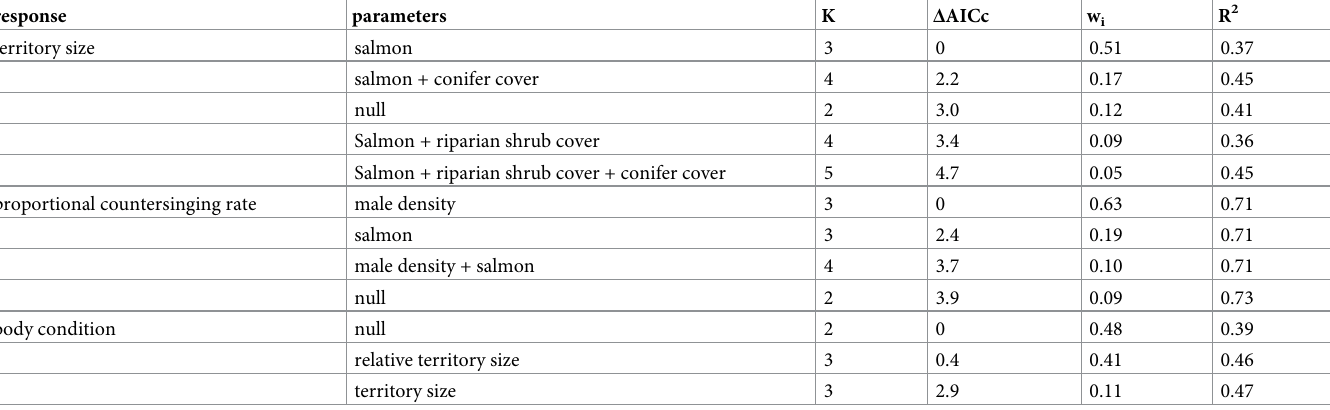
Table 1. AICc model selection analysis of linear regressions (models presented: Δ AICc < 5) describing Pacific wren territory size, countersinging rate, and body condition response variables predicted by salmon biomass, wren density and environmental metrics. Year (fixed effect) and stream (random effect) were included as variables in all models but are excluded from the table for